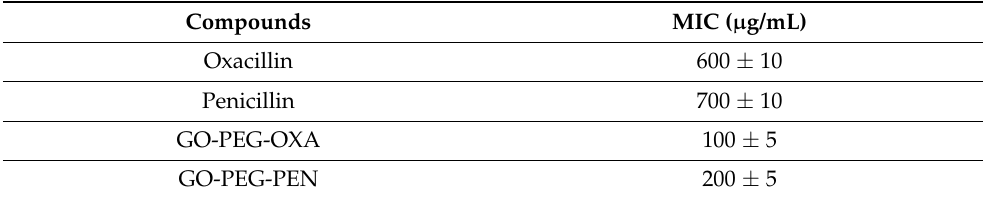
Table 3. MIC values of the compounds against MRSA.